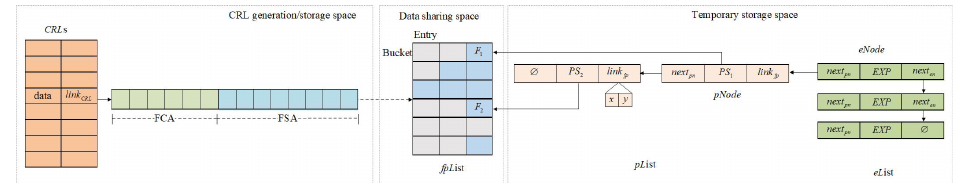
Figure 4. Improved Morton